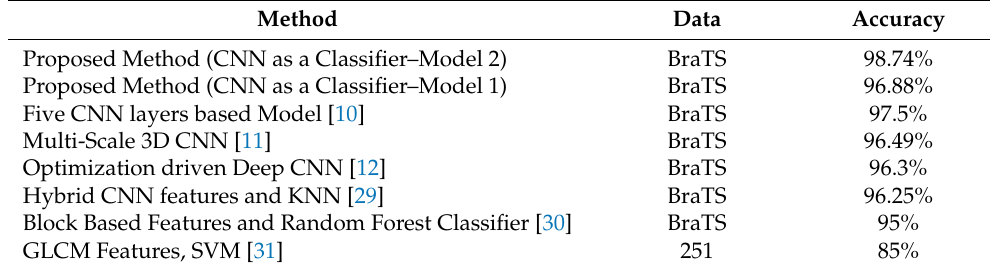
Table 10. Comparison of the proposed method for brain MR Images Classification with latest literature